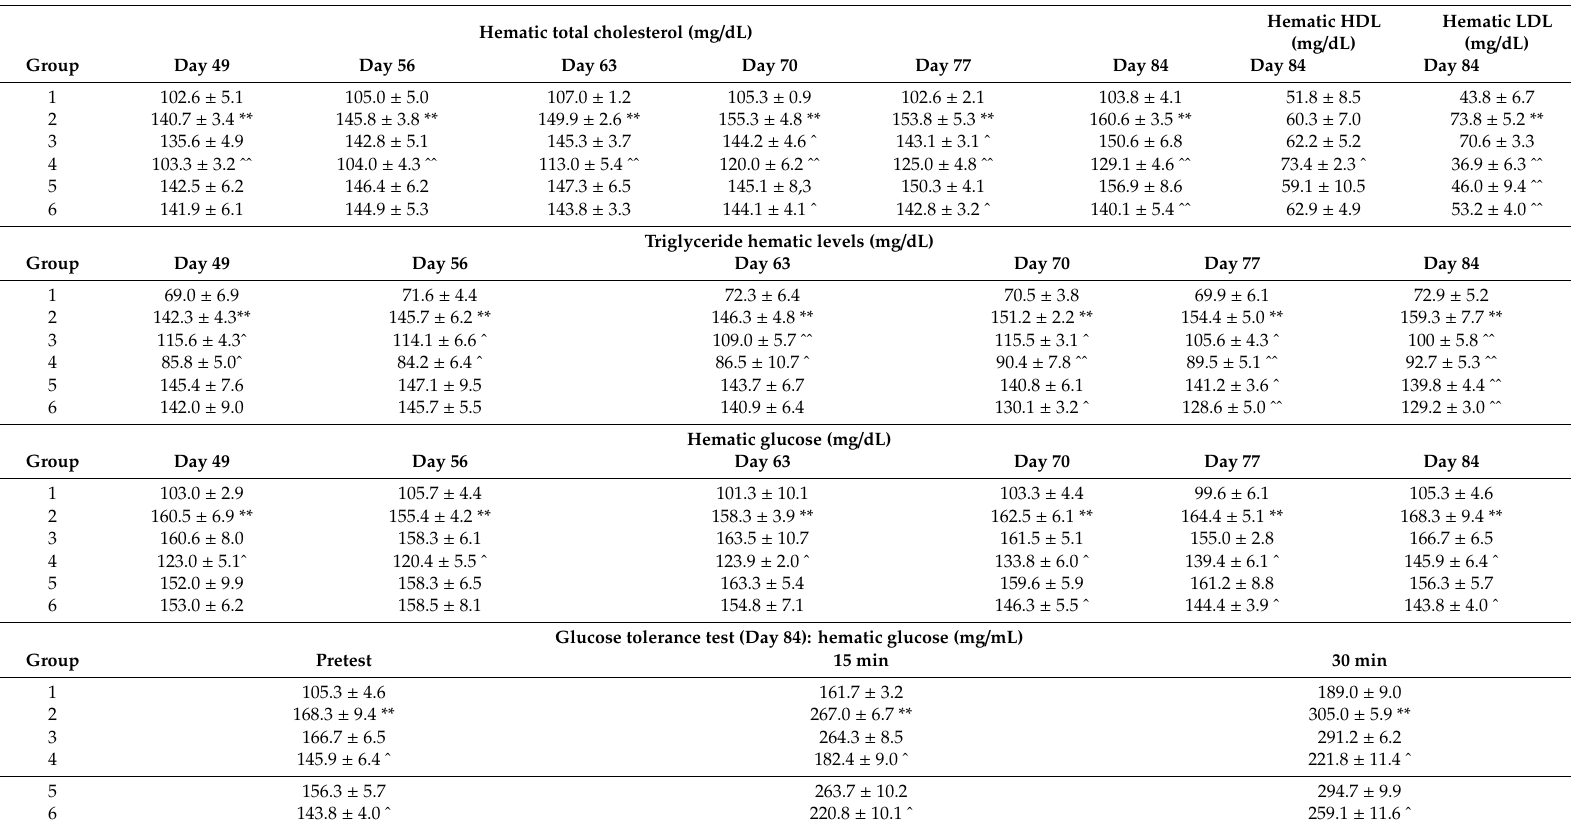
Table 4. Hematic parameters throughout the study: values of cholesterol, triglyceride and glucose from Day 47–Day 84; glucose tolerance test on Day 84. Group 1: standard diet + vehicle; group 2: HFD + vehicle; group 3: HFD + AP-NHm 1 co-treatment; group 4: HFD + AP-NHm 2 co-treatment; group 5: HFD + AP-NHm 1 post-injury; group 6: HFD + AP-NHm 2